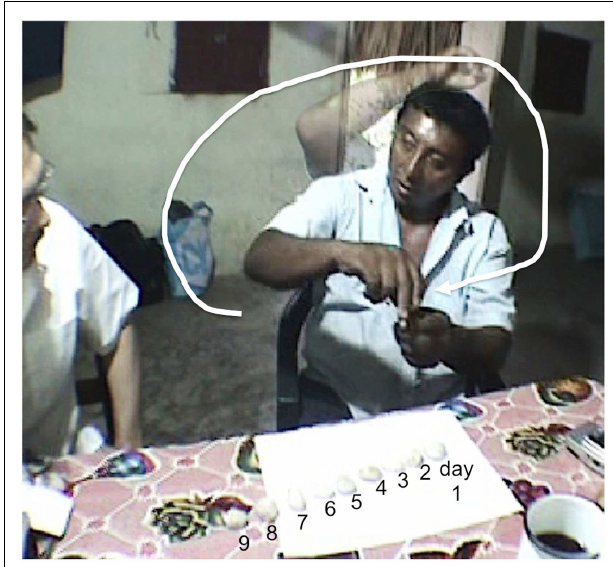
FIGURE 9 | Organization of the days during the Holy